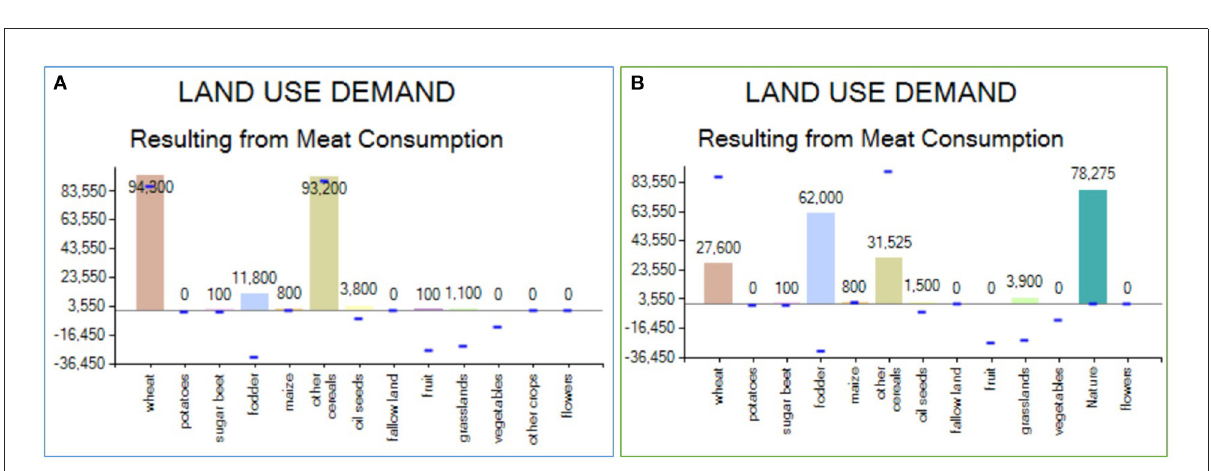
FIGURE12 Assessment of scenario proposed by Group 2. (A) Reference, (B) Group 2’s